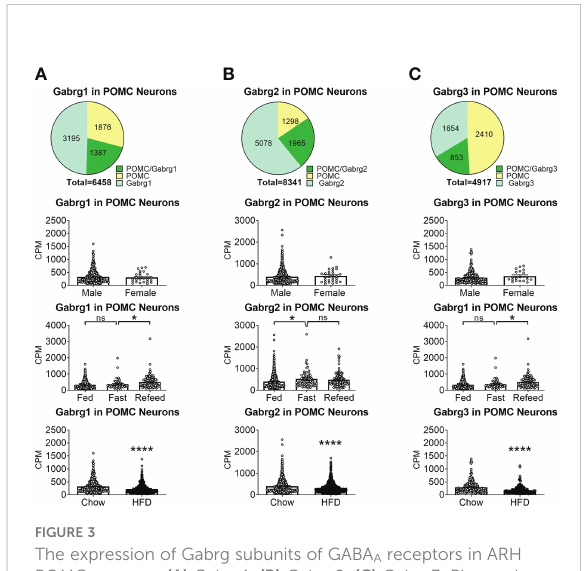
FIGURE 3 The expression of Gabrg subunits of GABA A receptors in ARH POMC neurons. (A) Gabrg1, (B) Gabrg2, (C) Gabrg3. Pie graphs and bar graphs were made the same way as described in Figure 1. ns, not signi fi cant. *, ****P < 0.05 or 0.0001 in unpaired t-tests.